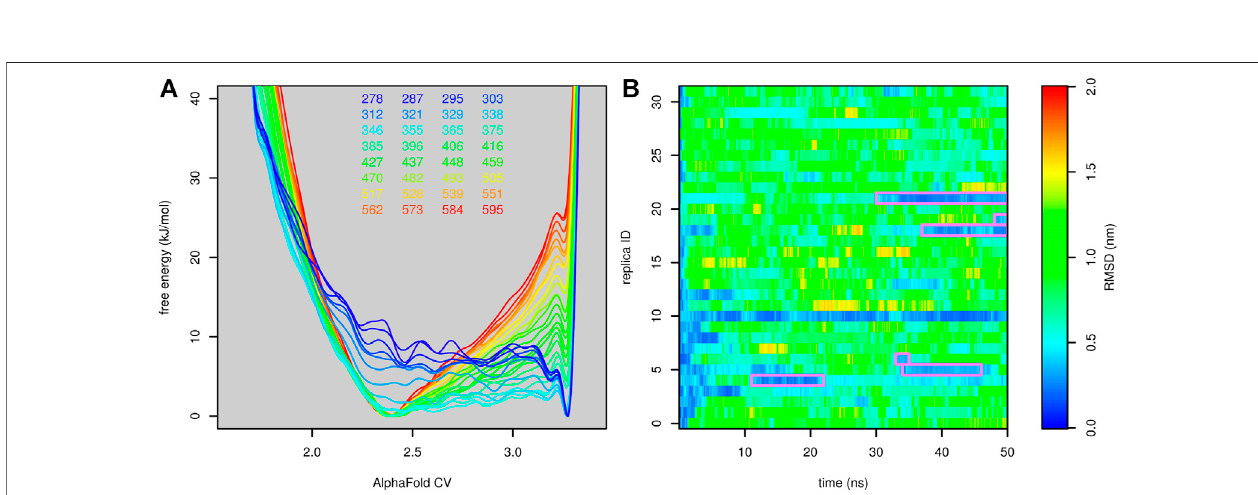
FIGURE 9 | Results of parallel tempering metadynamics simulation of β -hairpin with AlphaFold collective variables. (A) Free-energy surfaces calculated at different temperatures and (B) pro fi les of RMSD as a function of time calculated for demultiplexed trajectories.